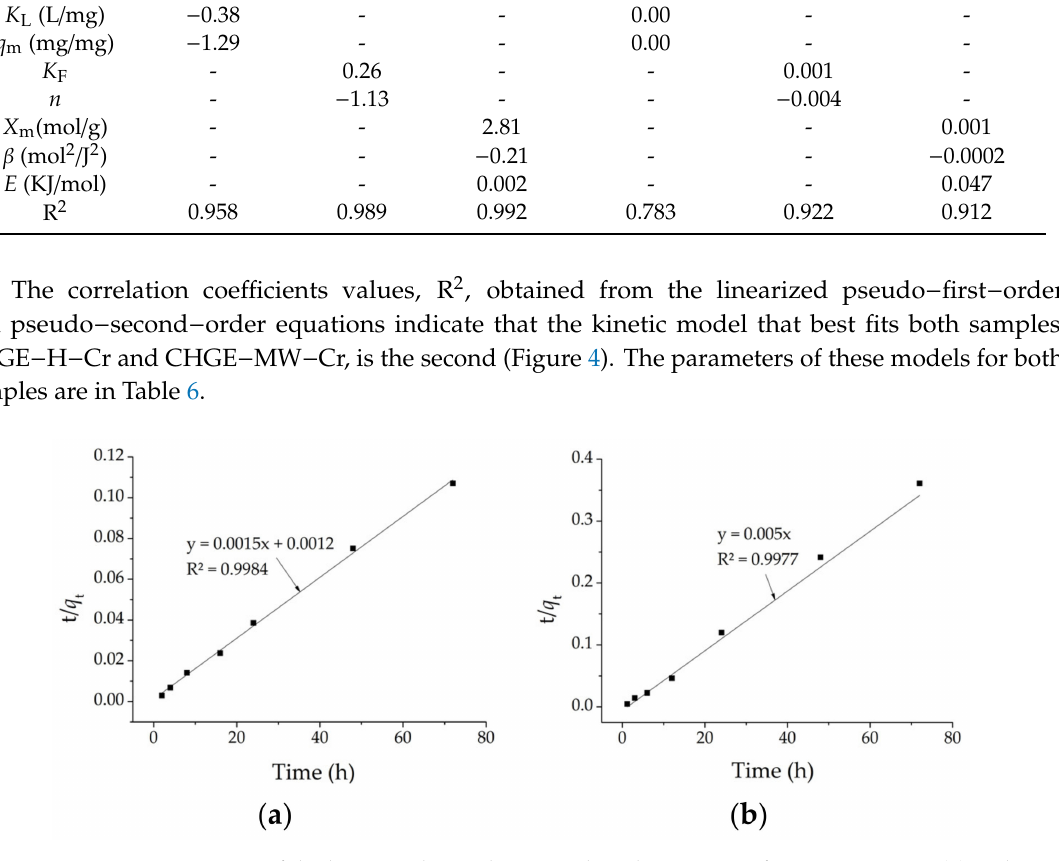
Figure 4. Representation of the linearized pseudo − second − order equation for CHGE − H − Cr ( a ) and CHGE − MW − Cr ( b )